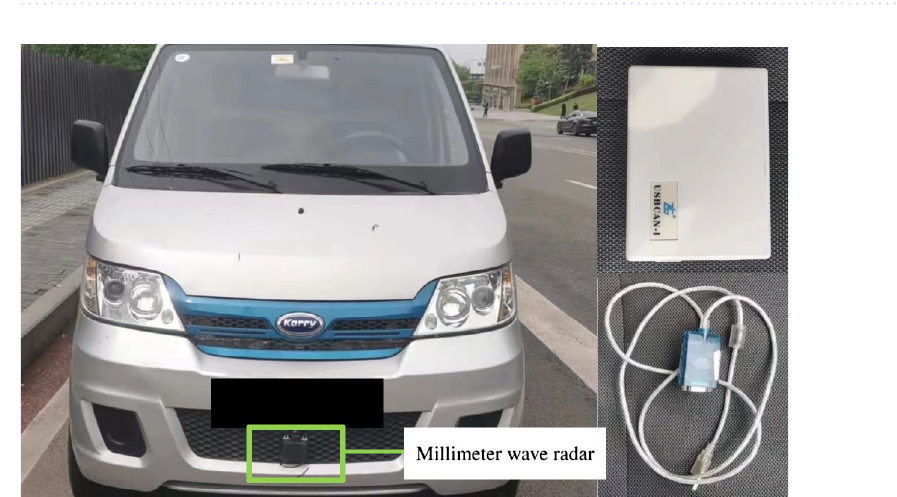
Figure 7. Driver characteristic parameter identification test program flow.